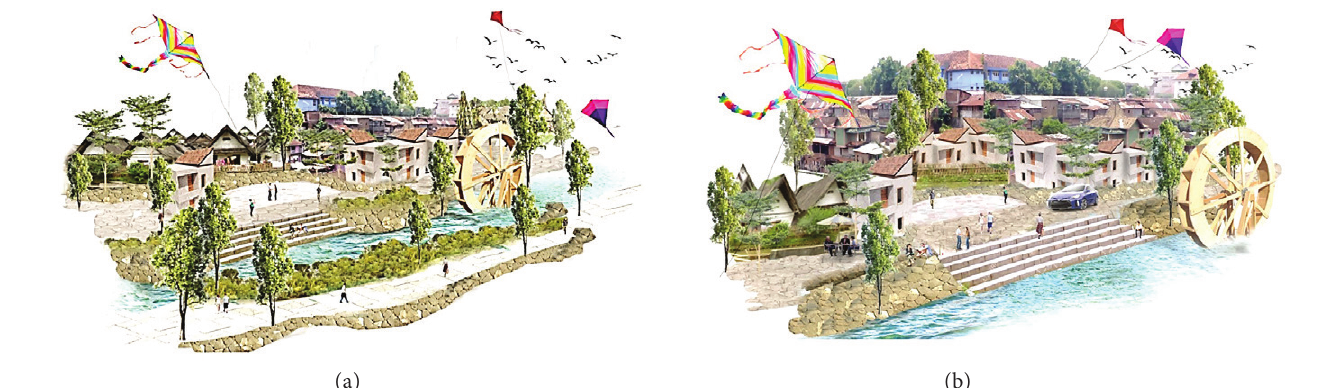
Figure 9. (a); (b) The atmosphere of the water wheel